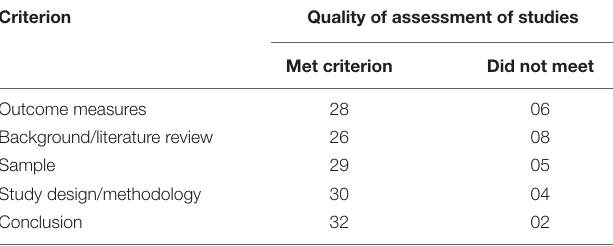
TABLE 3 | Summary of quality assessment by